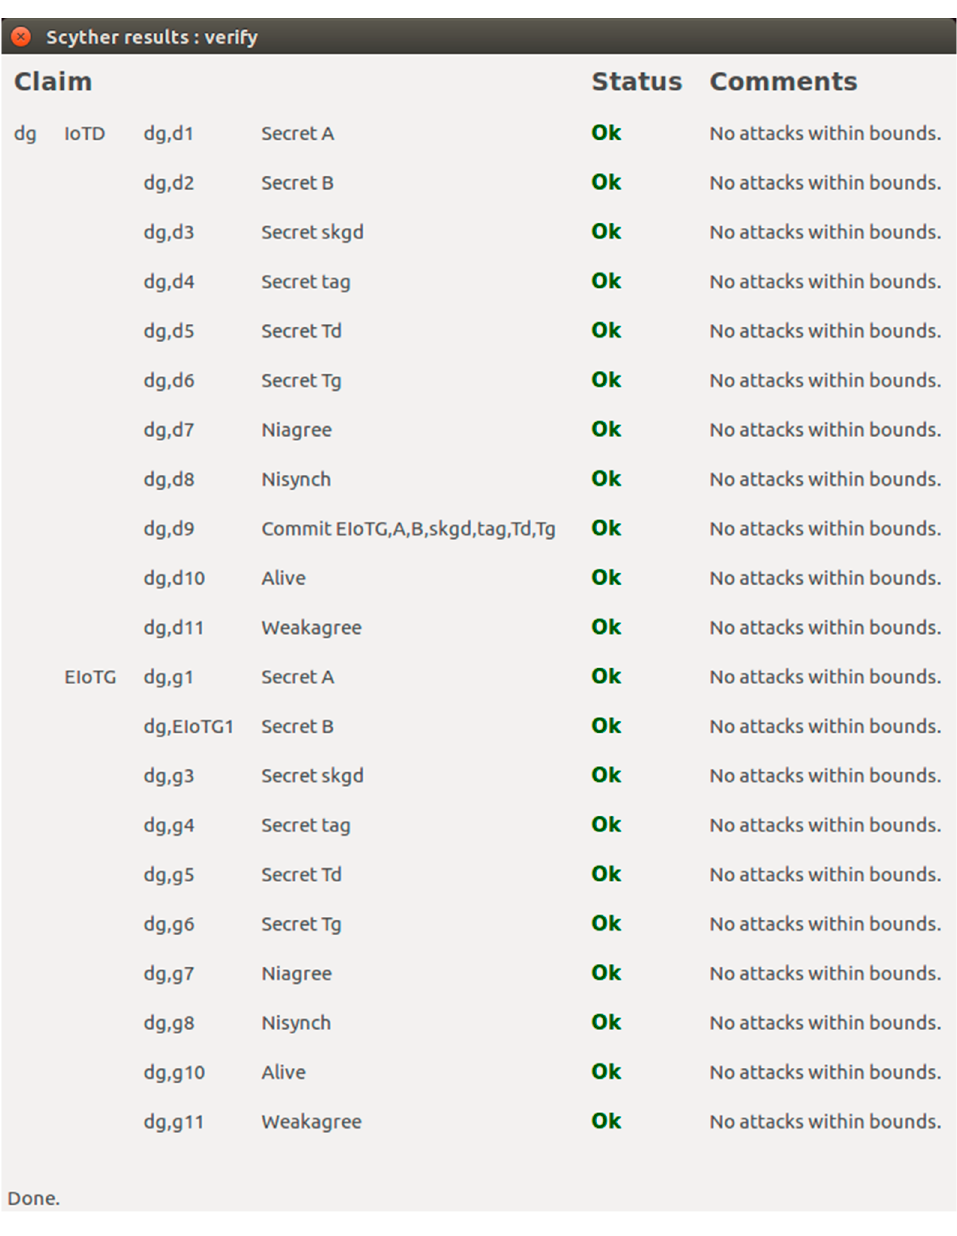
Figure 17. Scyther verification result for session key initialization between IoTD and EIoTG.